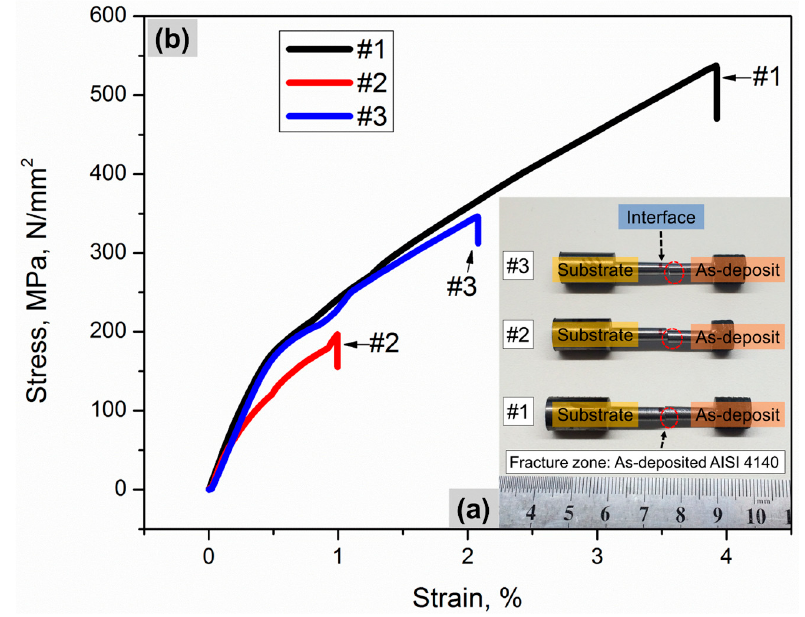
Figure 3. ( a ) Hybrid specimens that fractured at as-deposited zone indicated by dotted circles after tensile testing and ( b ) the corresponding stress-strain curves. Table 1. Tensile properties comparison between hybrid samples and the wrought counterpart.